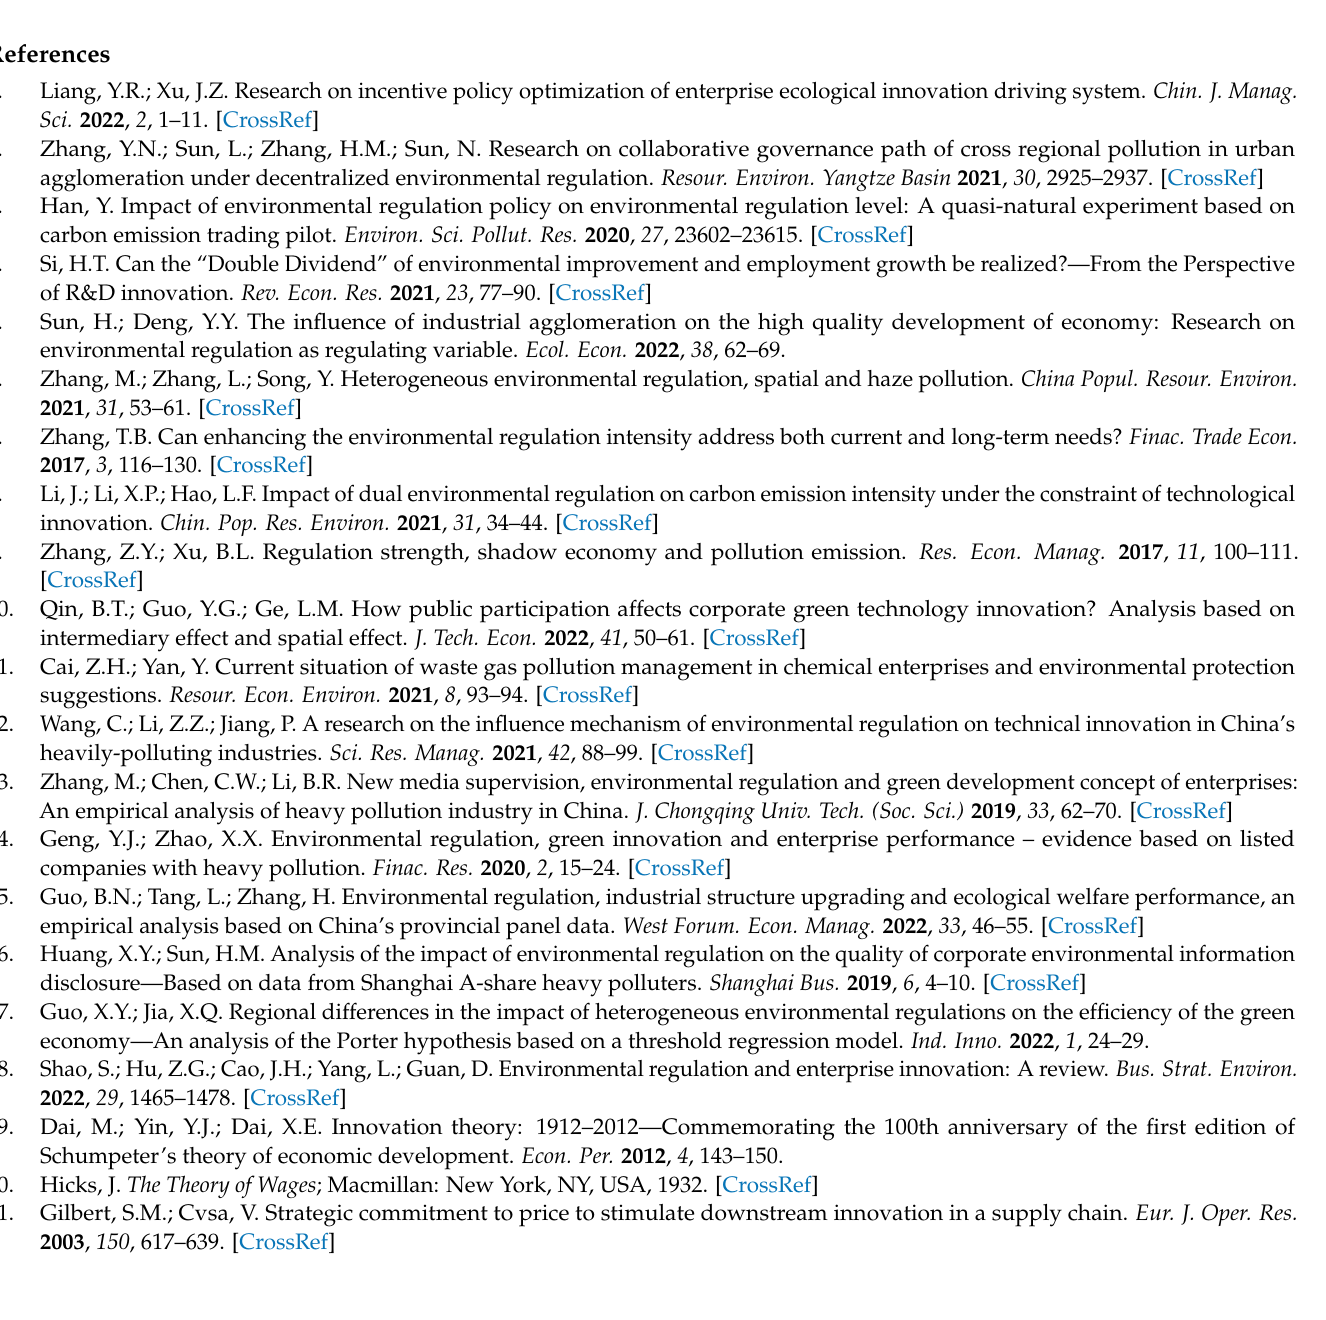
Table A8. Questionnaire for sustainability performance. Item or Indicator